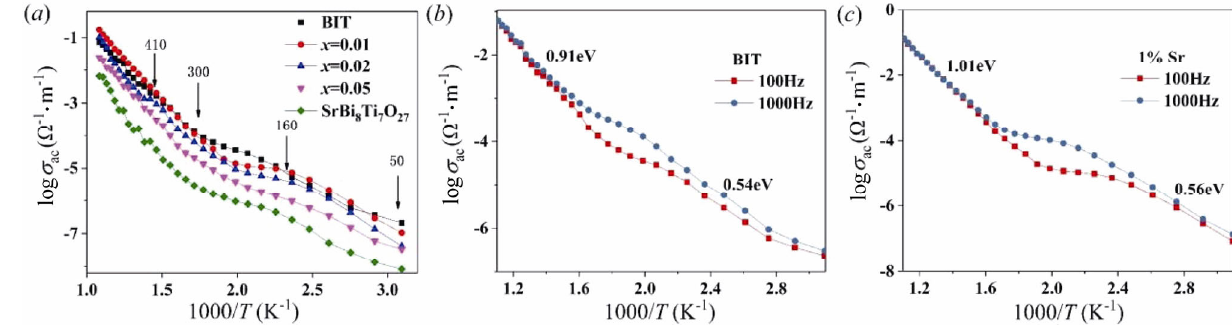
Fig. 7 (a) log σ ac as a function of 10 3 / T for different compositions at 100 Hz; (b) log σ ac of BIT ceramic at 100 Hz and 1 kHz; (c) log σ ac of 1%Sr ceramic at 100 Hz and 1 kHz.